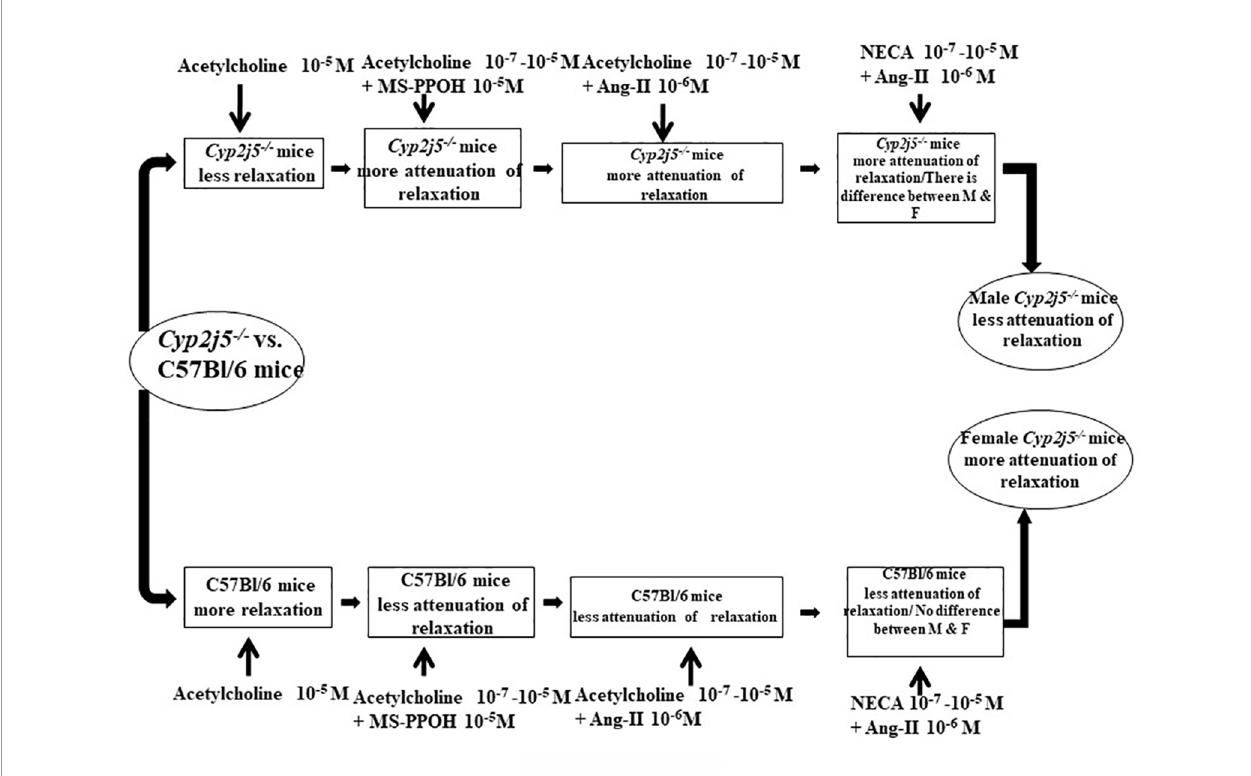
FIGURE 6 | Flow diagram: comparison between Cyp2j5 − / − vs . C57Bl/6 mice treated with acetylcholine, acetylcholine + MS-PPOH, acetylcholine + angiotensin II (Ang-II), 5'-N-ethylcarboxamidoadenosine (NECA), NECA + Ang-II, and CGS 21680 + dibromo-dodecenyl-methylsul fi mide (DDMS) +